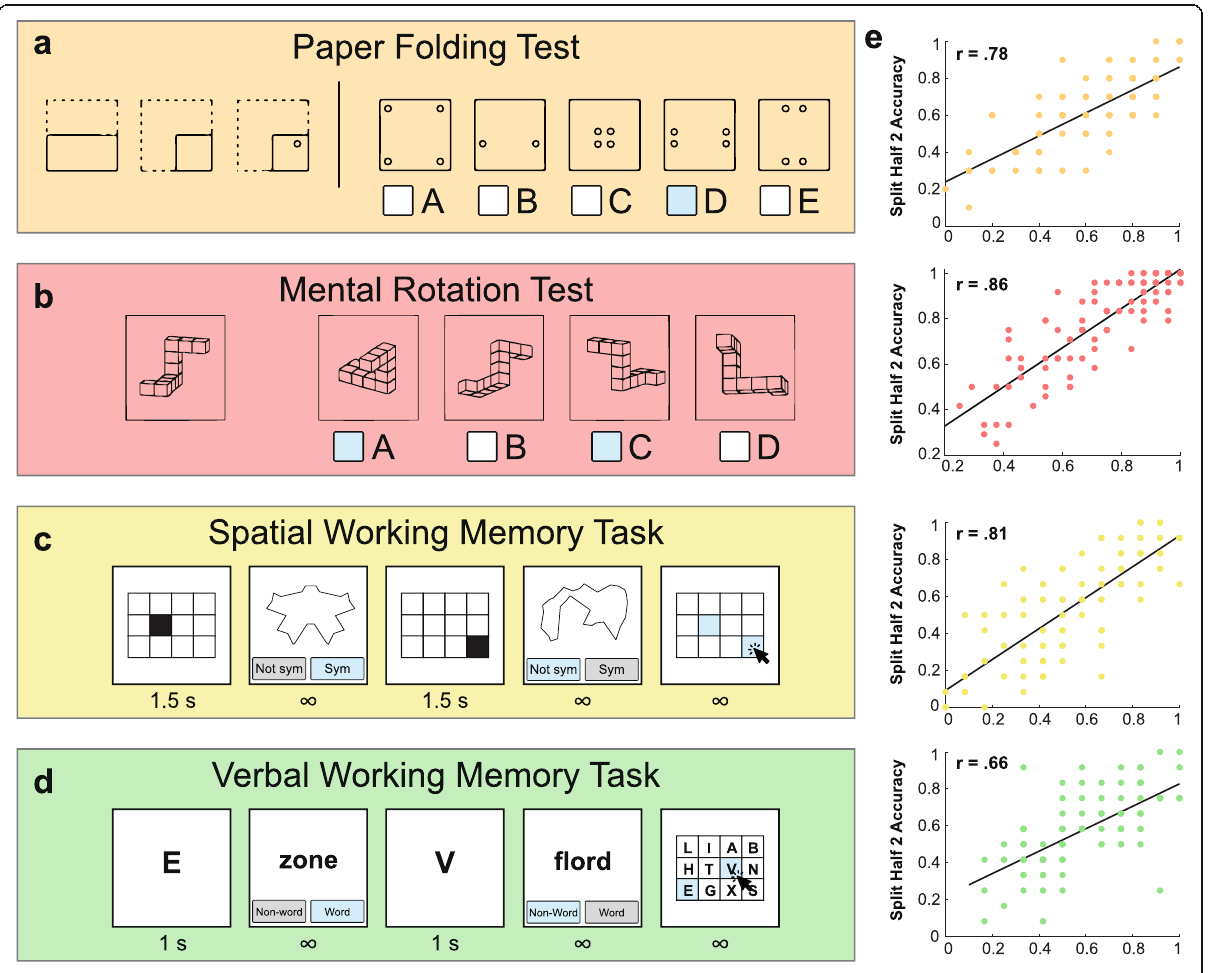
Fig. 2 Spatial reasoning and working memory tests. a Example item from the Paper Folding Test (Ekstrom, Dermen, & Harman, 1976). The three items on the left indicate how a square piece of paper is folded and hole-punched. Participants must determine where the holes would be located if the paper was unfolded back to its original form. b Example question from the Mental Rotation Test (Peters et al., 1995; Shepard & Metzler, 1971; Vandenberg & Kuse, 1978). Participants must determine which two items on the right are rotated versions of the item on the left. The remaining two incorrect choices are structurally different to the target item. c General layout of the spatial working memory task. Participants were required to remember a series of filled in grid positions while performing a secondary symmetry judgement (see “ Methods ” ). The symmetry judgement required participants to determine whether the shape was perfectly symmetrical when split vertically down the middle. The number of grid positions that participants were required to hold in memory varied between three and eight on different trials. At the end of each trial, participants reported the remembered grid positions by clicking within a blank grid (far right panel). d General layout of the verbal working memory task. Participants were required to remember a series of letters while performing a secondary lexical decision task (see “ Methods ” ). In the lexical decision task, participants reported whether a word was a real or fake English word. The number of letters that participants were required to hold in memory varied between three and eight on different trials. At the end of each trial, participants reported the remembered series of letters by clicking within a grid (far right panel). e Split-half reliability for each task. The trials from each task were split into two sets and performance was computed for each independent half (each data point represents the performance of one participant). All split-half correlations were statistically significant ( p <